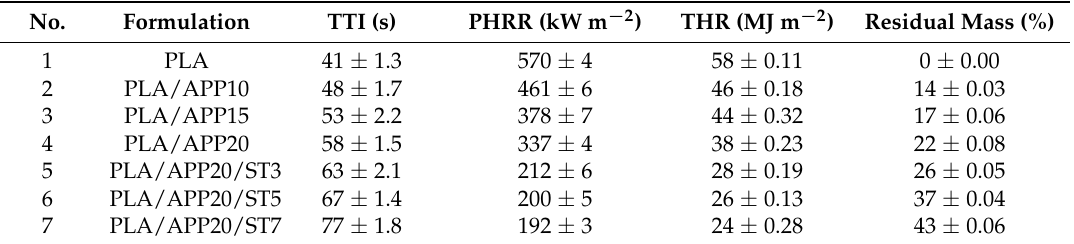
Table 2. Cone calorimetry data for pure PLA, PLA/APP, and PLA/APP/ST